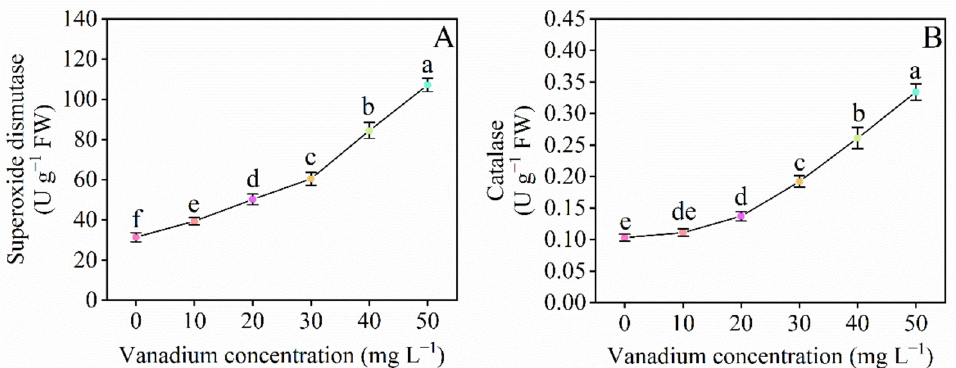
Figure 9. Effect of vanadium on Superoxide dismutase ( A ) and Catalase ( B ) in pepper seedlings. Means ± SE, n = 4, significant differences are exhibited by lowercase letters (at p < 0.05), according to Fisher’s least significant difference test.